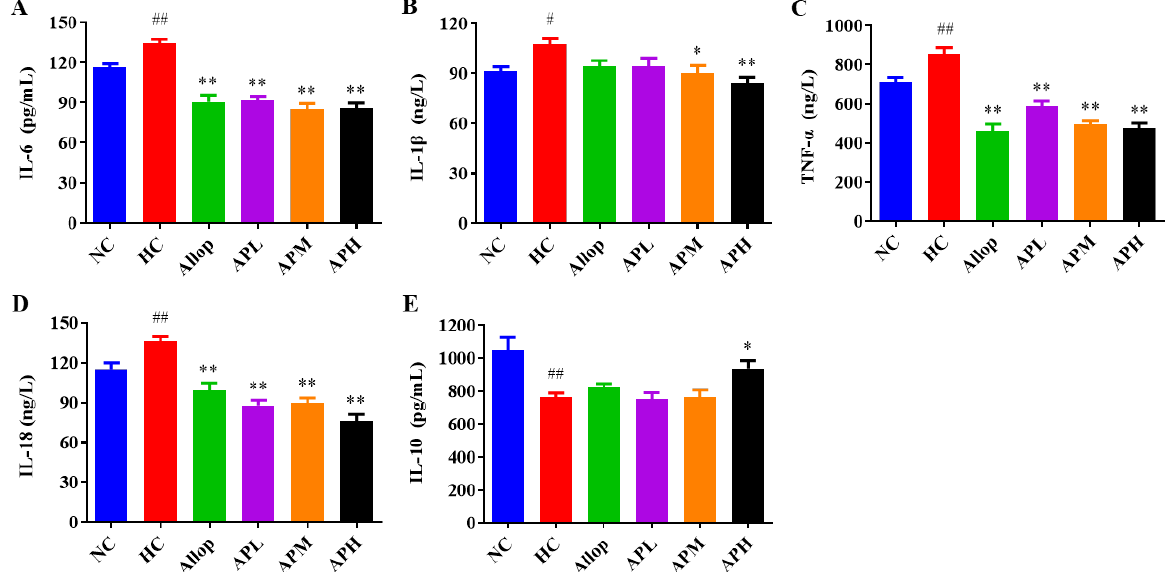
Figure 4. Apigenin decreases serum levels of IL-6 ( A ; pg/mL, n = 10), IL-1 β ( B ; ng/L, n = 10), TNF- α ( C ; ng/L, n = 10), and IL-18 ( D ; ng/L, n = 10), and increases serum levels of IL-10 ( E ; pg/mL, n = 8). ## p < 0.01, # p < 0.05 vs. the NC group. ** p < 0.01, * p < 0.05 vs. the HC group.